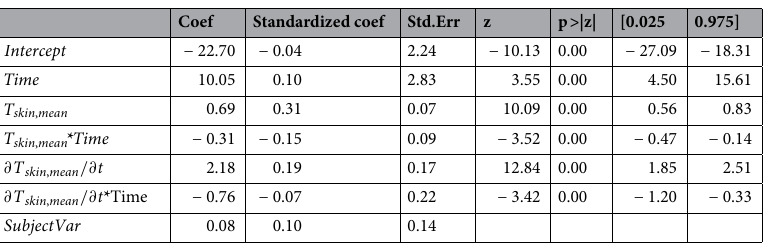
Table 11. Normal and standardized (Z-score) regression coefficients for the predictors of the thermal sensation vote in the MLM (727 observations and 14 groups).